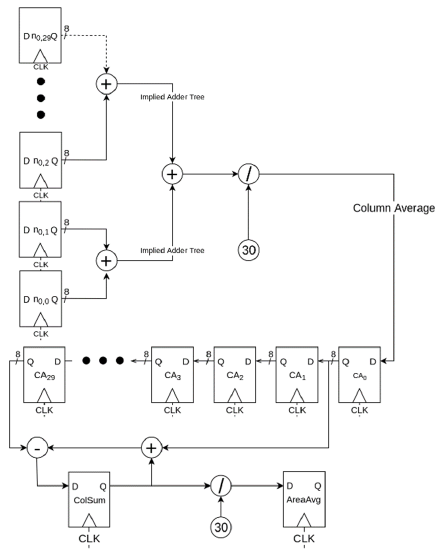
Figure 9. The graphical flow of the efficient averaging finder.